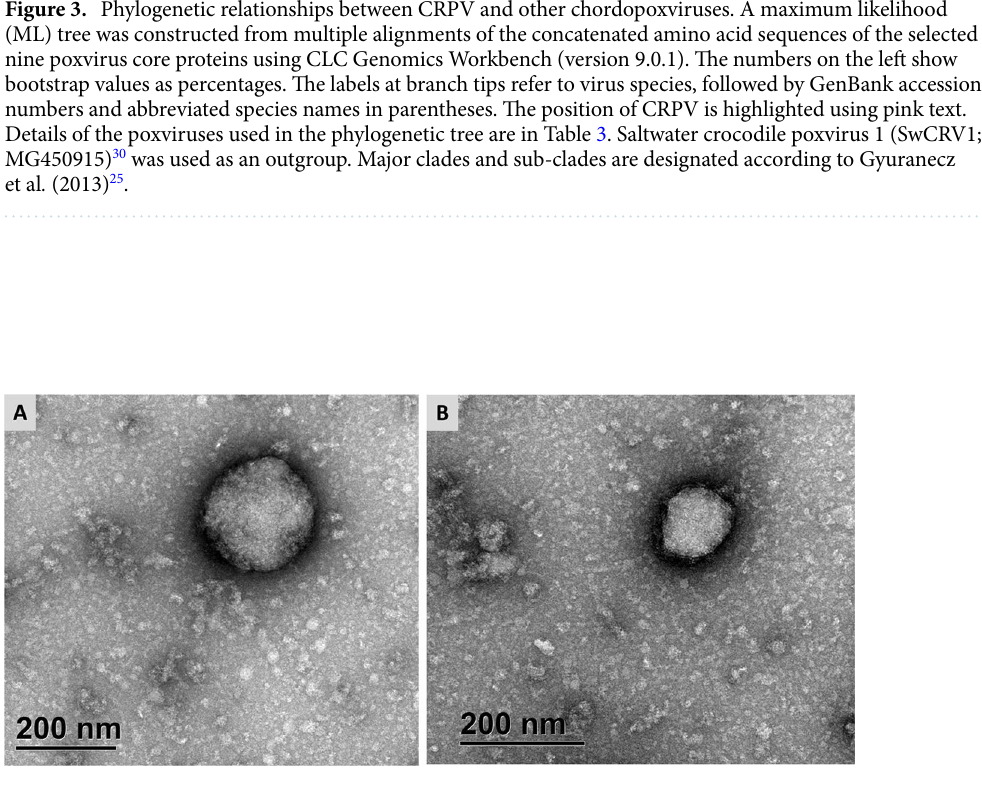
Figure 4. Transmission electron microscopic analysis of negatively stained cutaneous tissue sourced from a passerine bird, Australian little crow. Crowpox virus particles showed the presence of intracellular mature virion ( A ) and immature virion ( B